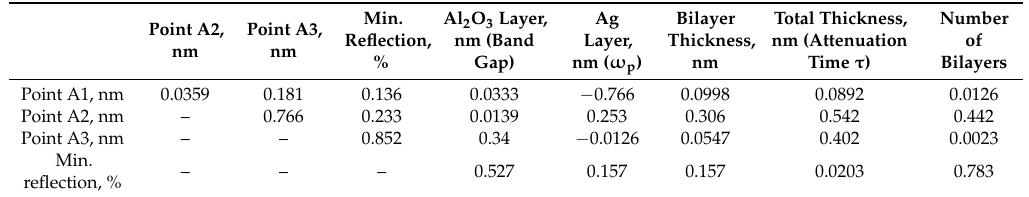
Table 2. Correlation of reflection spectra vs. characteristics of plasmon resonance and architecture parameters of MIM multilayer Al 2 O 3 /Ag